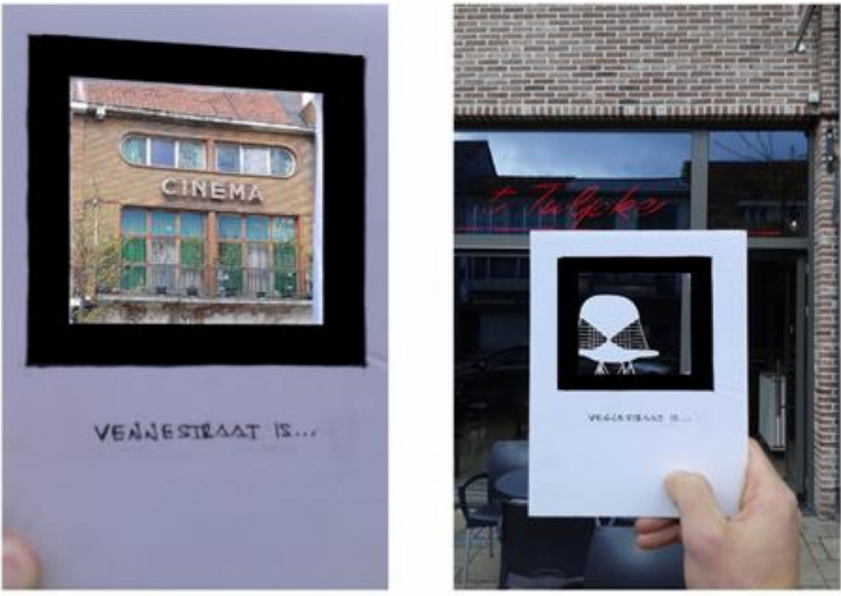
Figure 5. Capturing mental